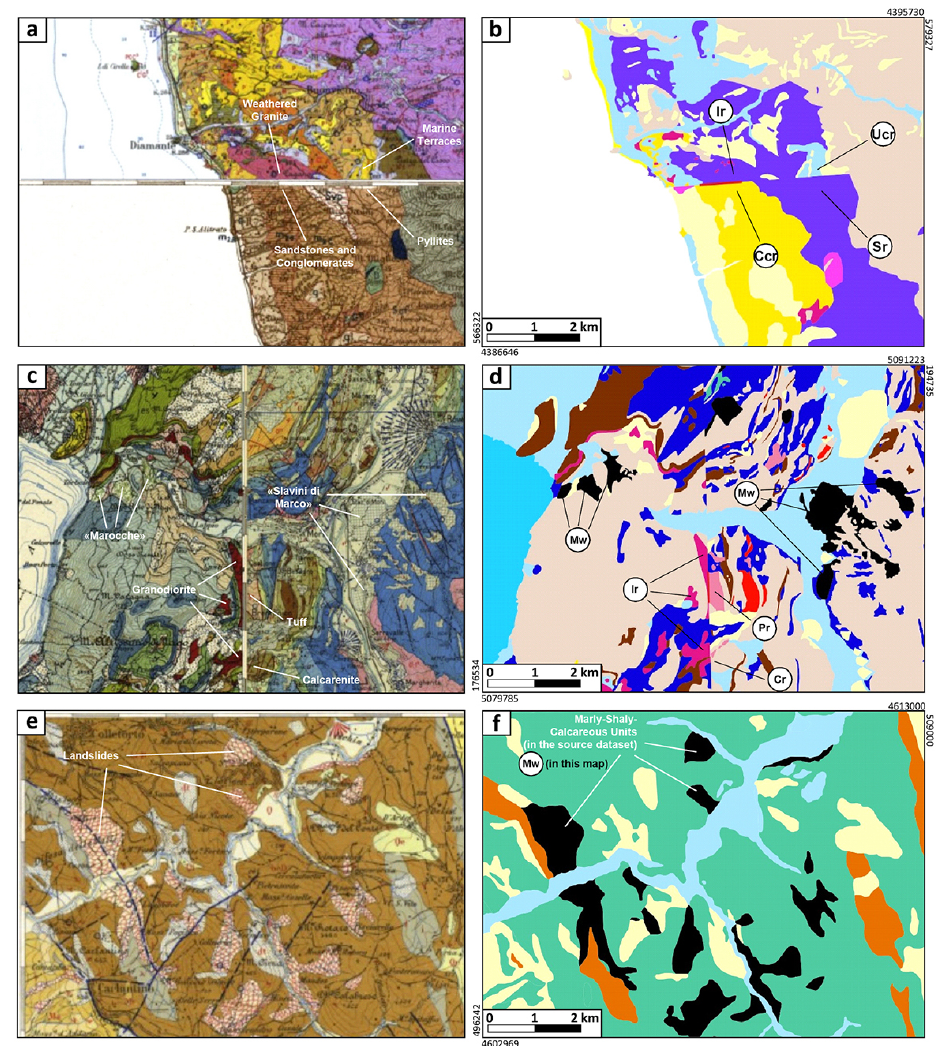
Figure 3. The main problems of the source dataset highlighted through the comparison of representative areas as they appear in the published raster version of the geological sheets (a, c, e) and in our reclassified vector map (LMI) (b, d, f) . Vector map legend – Ir (intrusive rocks), Ucr (unconsolidated clastic rocks), Ccr (consolidated clastic rocks), Sr (schistose rocks), Pr (pyroclastic rocks), Cr (carbonatic rocks), Mw (mass wasting). Examples of errors related to locally wrong rock classification and inhomogeneity problems at the boundary between geological sheets of different years are shown in panel (a) (year 1969 – N sheet no. 220 vs year 1890 – S sheet no. 228) and in panel (c) (year 1948 – W sheet no. 35 vs year 1966 – E sheet no. 36). Examples of local/dialectal terms in the geological description are shown in panel (c) (“Marocche” and “Slavini di Marco” for mass wasting). Examples of errors related to incorrect database compilation are shown comparing panels (e) and (f) . Panels (a) , (c) , and (e) include sheet nos. 220, 228, 35, 36, and 163 as visualized in raster form at the ISPRA website (Table 1, ID